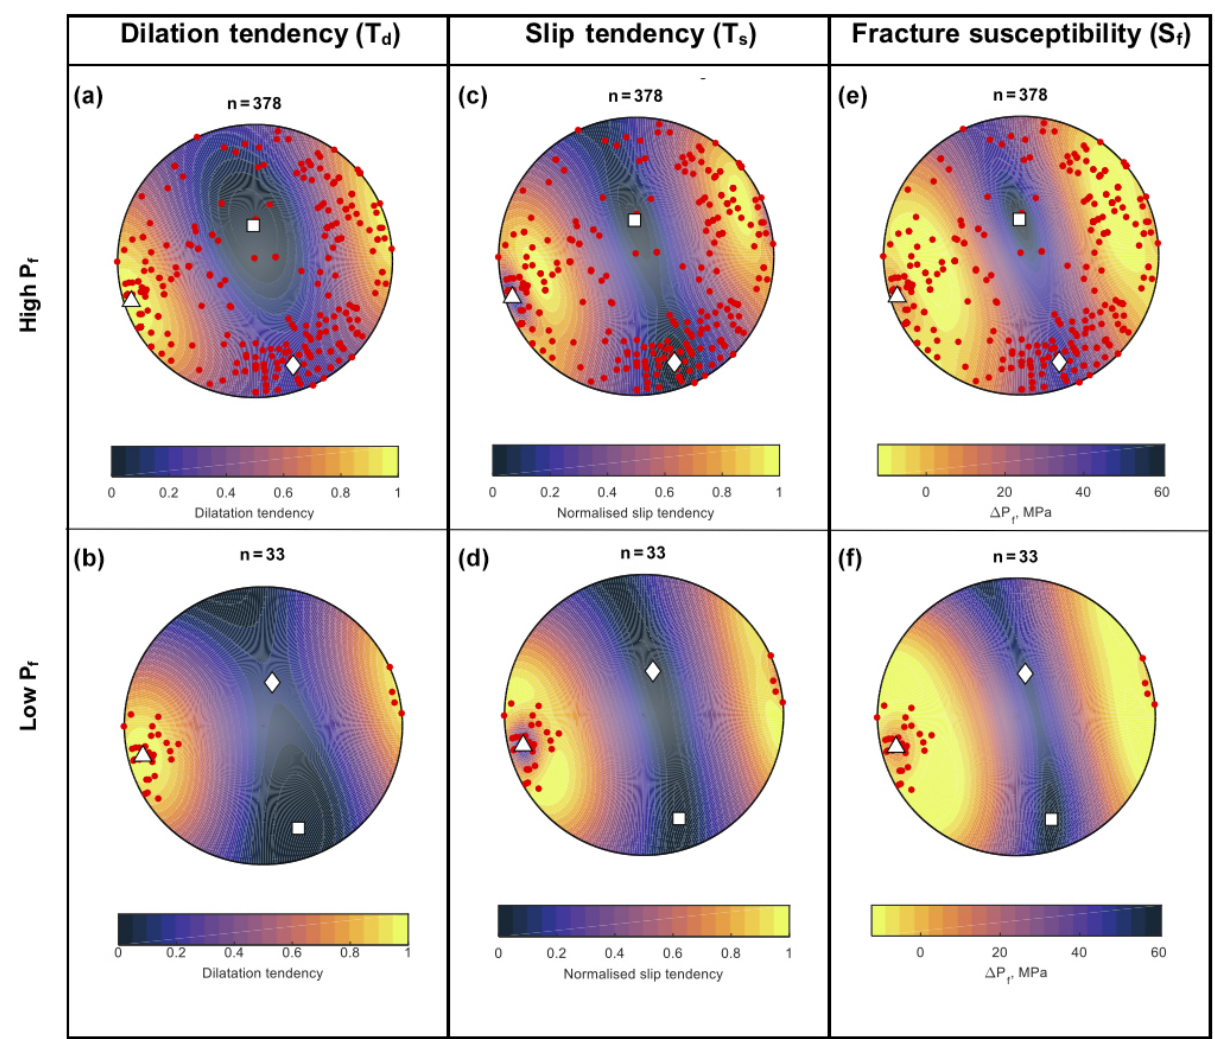
Figure 9. Lower hemisphere equal area projection for dilation tendency, slip tendency and fracture susceptibility in a given fluid pressure condition and for a specific stress state (Fractend code available via Healy, 2017). (a) and (b) represent dilation tendency for high and low P f . (c) and (d) represent slip tendency for high and low P f . (e) and (f) fracture susceptibility for high- and low- P f conditions, respectively. Warm color zones in (a) and (b) represent vein orientations with a higher propensity for tensional opening. In (c) and (d) warm colors indicate vein attitudes that suffered shearing. In (e) and (f) the warm color zones stand for vein attitudes that are more prone to reactivate under low- P f variation. “Thermal” color scheme from Thyng et al. (2016). White square ( σ 1 ) , white diamond ( σ 2 ) and white triangle ( σ 3 ). n : number of